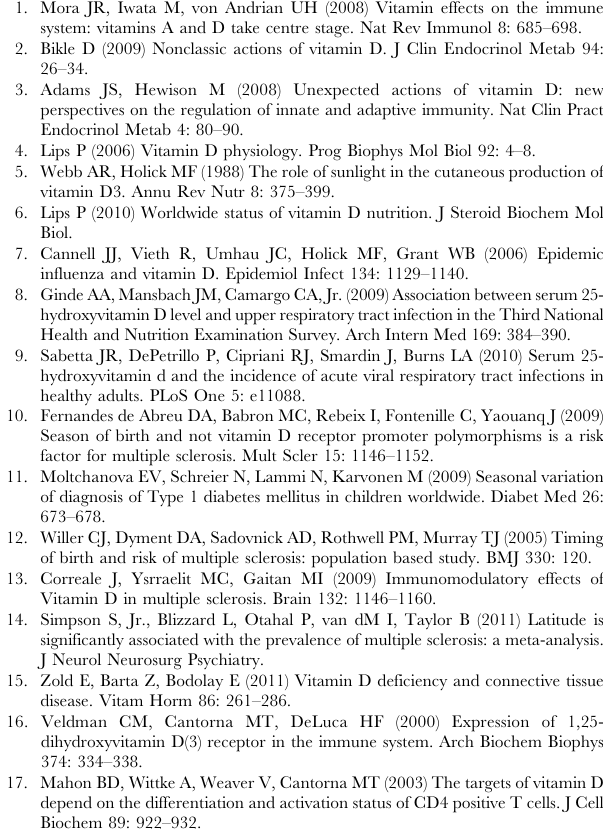
Figure 6. Seasonal variation in cytokine profile of CD4 + and CD8 + T cells. Percentage and the level of production on a per cell basis (MFI) of A) IFN c , B) IL-2 and C) IL-17 by CD4 + T cells; and of D) IFN c and E) IL-2 by CD8 + T cells analyzed by flow cytometry. PBMC isolated from 10 healthy volunteers and intracellular staining for cytokines was performed after the cells were stimulated with PMA plus ionomycin in the presence of brefeldin A. CD4 + T cells were defined as CD3 + CD8 2 . Data show results from 10 healthy donors. * p , 0.05 as compared to